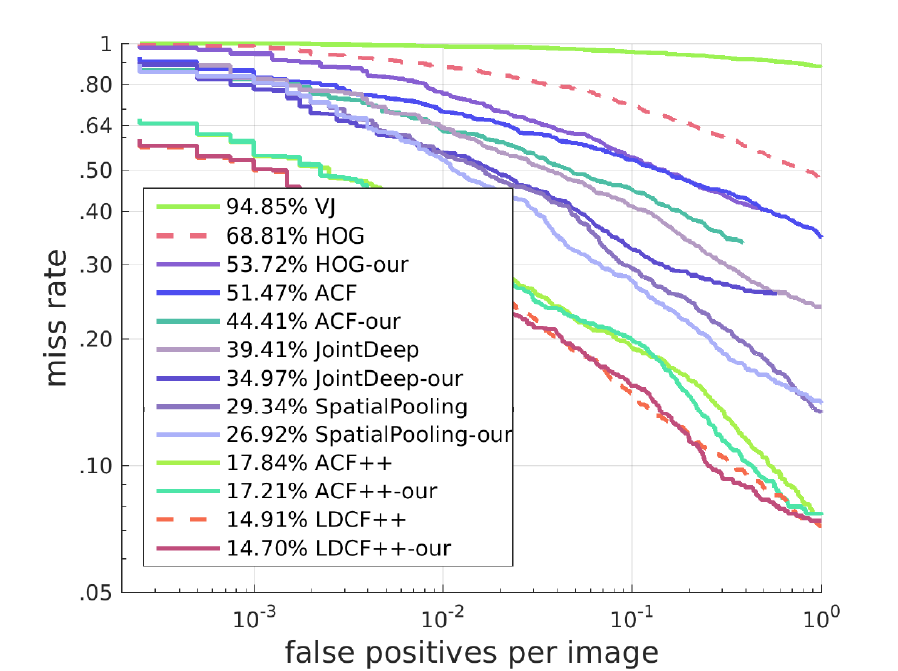
Figure 10. ROC curves of algorithms with and without our SROI.